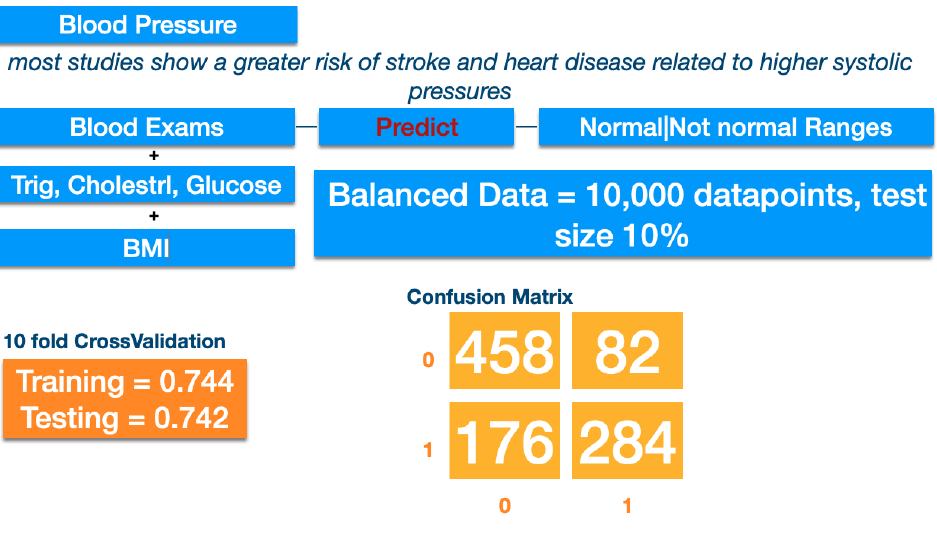
Figure 17. Blood pressure